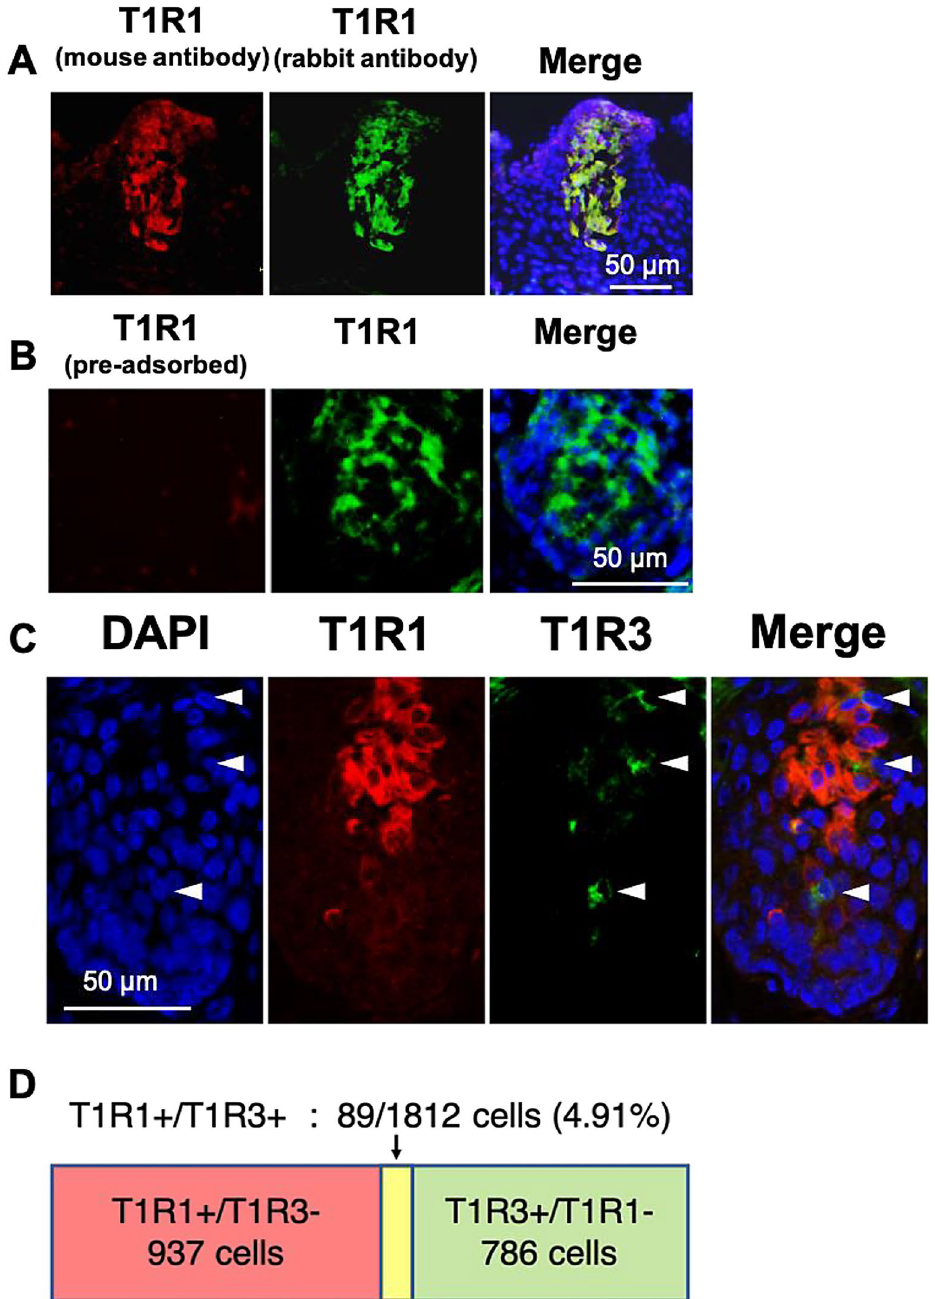
Figure 4. ( A ) The distributions of T1R1, labeled by the antiserum generated herein (host species: mouse) ( red ) and T1R1, labeled by the antiserum (host species: rabbit) ( green ) immunosignals in the oral tissues in the floor of the oral cavity of 6-day-old chicks. Nuclei were stained with DAPI ( blue ). ( B ) Diminished T1R1 ( red ) immunosignal by pre-incubation with the excess synthetic peptide in the taste bud cells, labeled by another T1R1 antiserum ( green ). Nuclei were stained with DAPI ( blue ). ( C ) The distributions of T1R1 ( red ) and T1R3 ( green ) immunosignals in the oral tissues in the palate of 6-day-old chicks. Nuclei were stained with DAPI ( blue ). Arrowheads: Taste bud cells labeled by T1R3. The images were representative and 35 images were analyzed. ( D ) The number and ratio of T1R1 + /T1R3 + cells (double-positive cells) among the T1R1 + or T1R3 + taste bud cells in the palate and floor of the oral